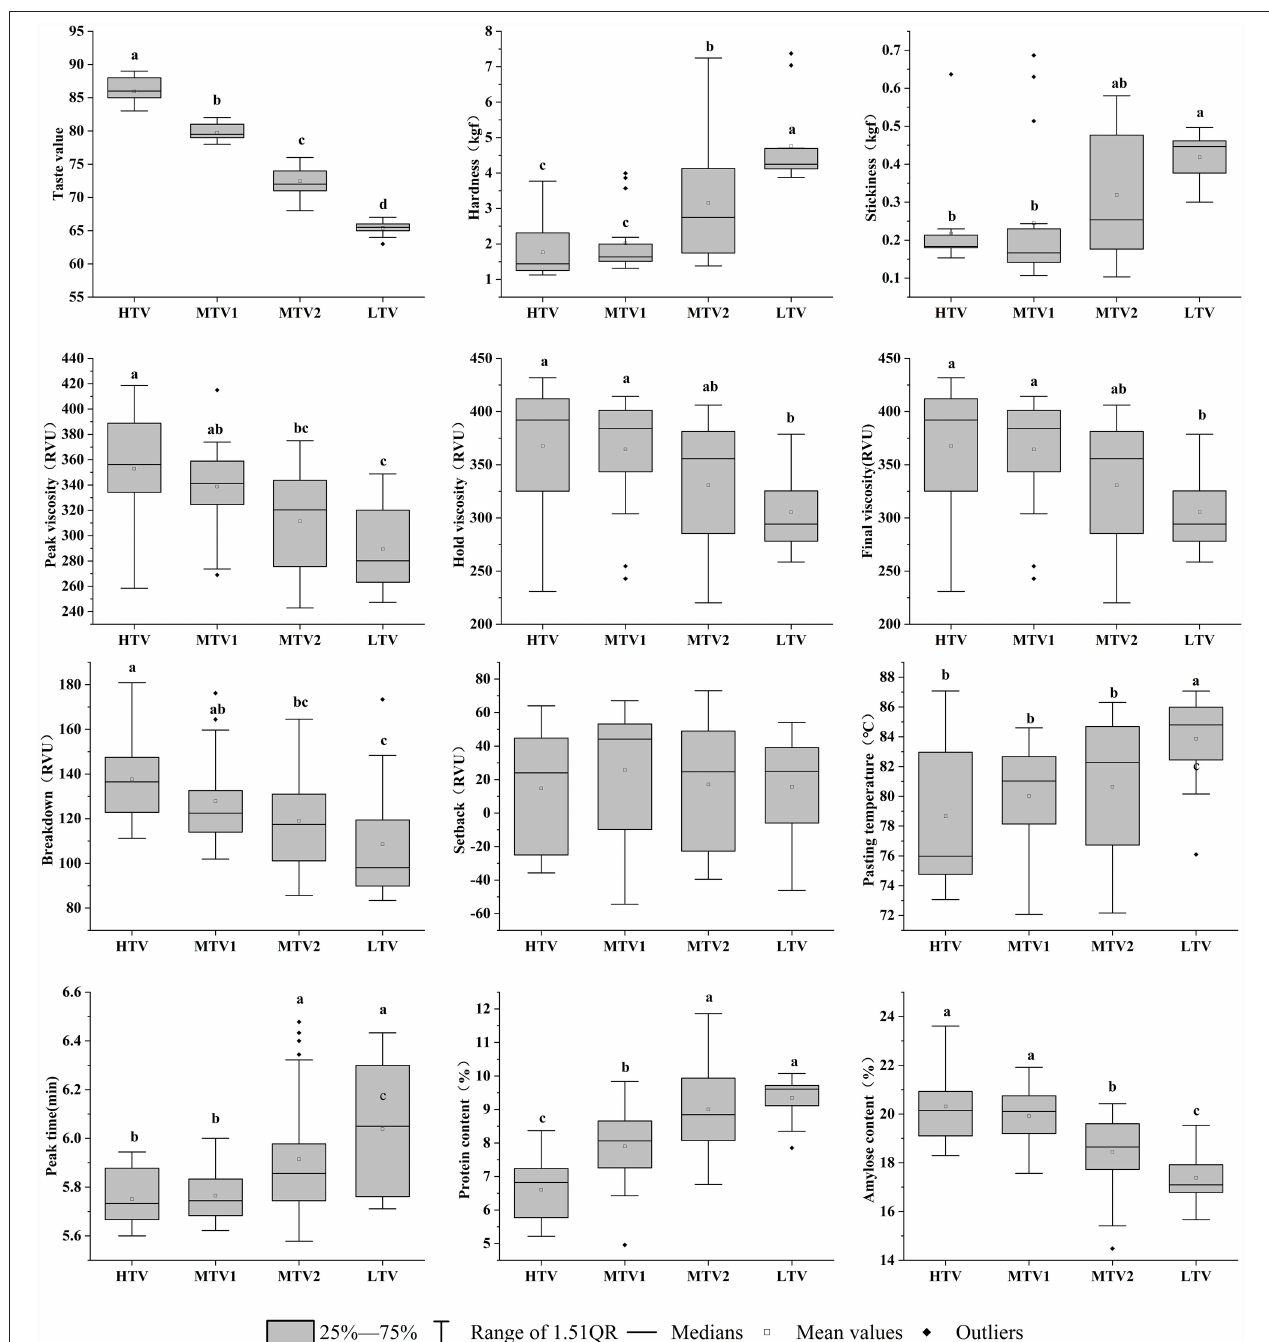
FIGURE 3 | Protein content, amylose content, taste values, and RVA profiles of three different types of rice. The value of different lowercase letters refers to significant difference at P < 0.05.